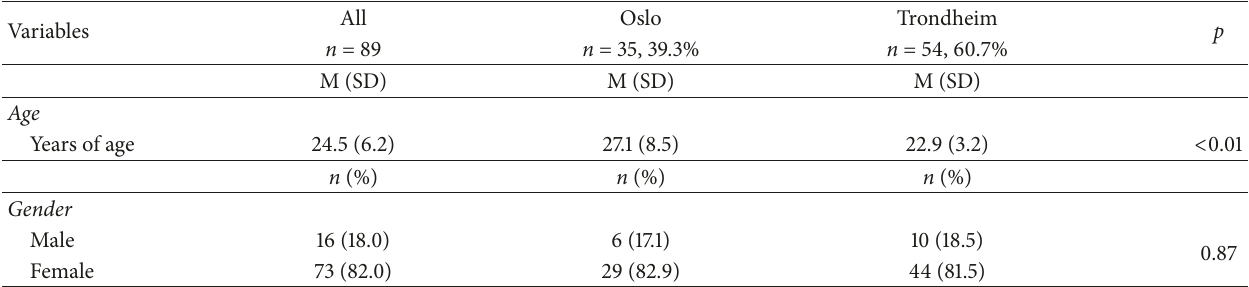
Table 1: Sample characteristics ( 𝑛 = 89